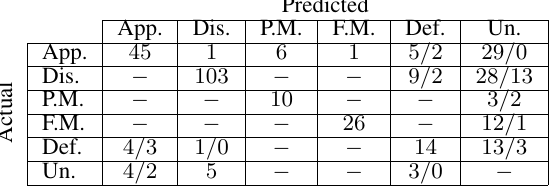
Table 1. The confusion matrix achieved by applying our method to the TUM City Campus dataset. Values after the slash result from excluding segmentation